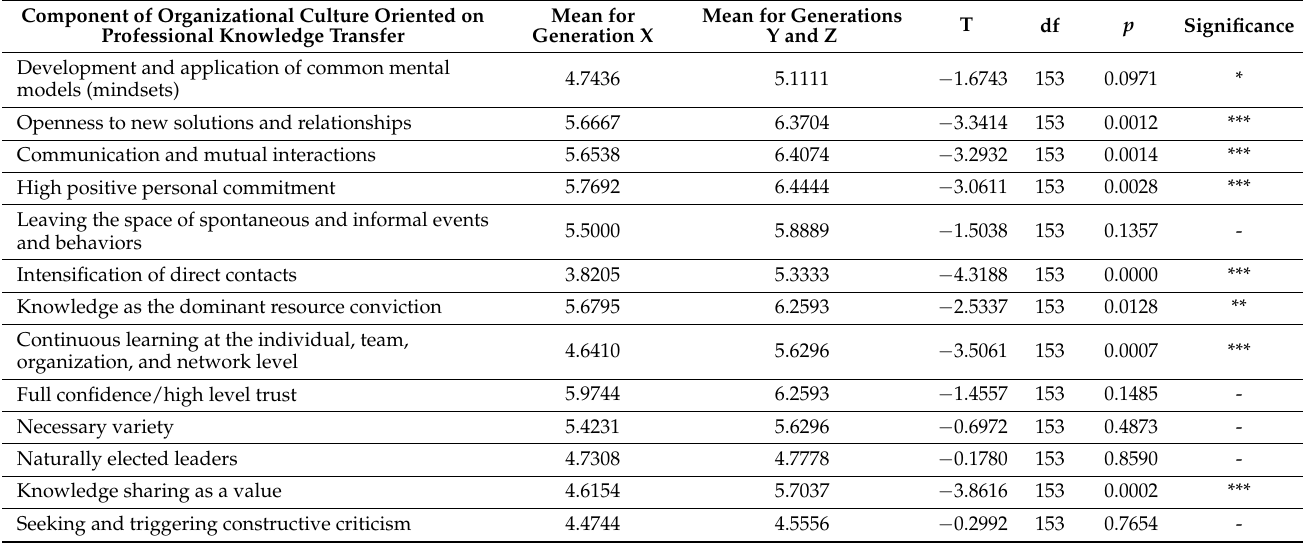
Table 8. T -test for variables of organizational culture oriented on professional knowledge exchange between IT specialists and partners compared to generations.